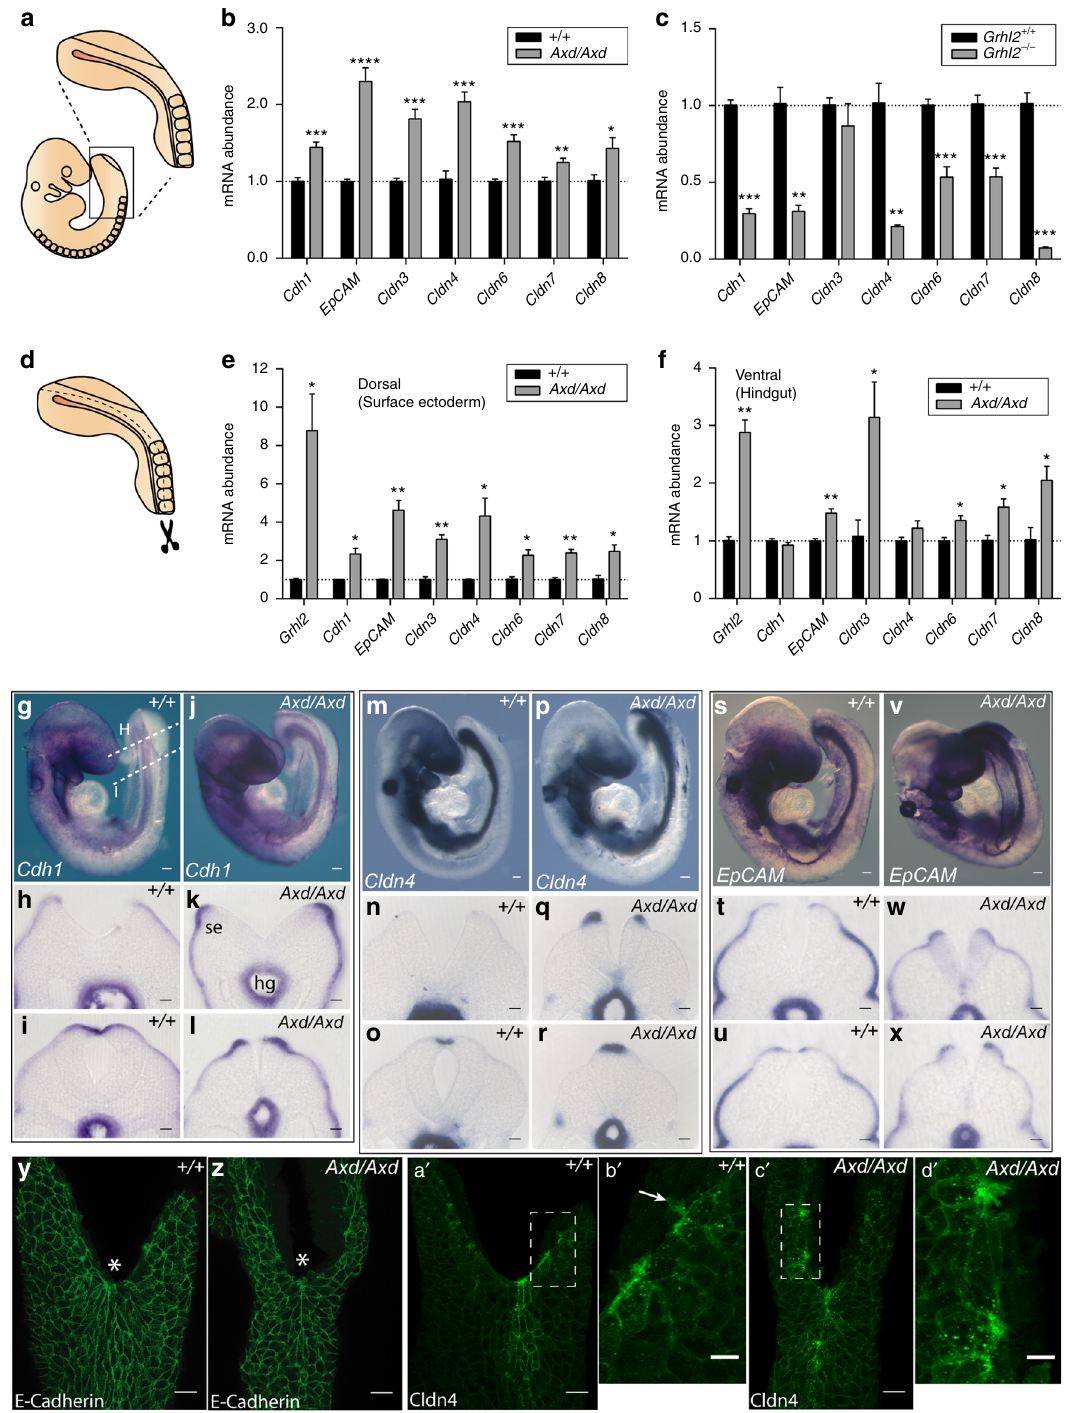
Fig. 3 Grhl2 regulates a molecular signature of epithelia in the surface ectoderm. a Schematic representation of an E9.5 embryo and caudal spinal region isolated for analysis. b – c qRT-PCR of Cdh1, EpCAM, Cldn 3,4,6,7, and 8 of samples derived from the whole-caudal spinal region (as in a ) ( n = 3 – 6 samples per genotype). d Schematic representation of the microdissection separating the dorsal (surface-ectoderm-containing) and the ventral (hindgut-containing) parts of the caudal spinal region. e , f qRT-PCR analysis of Cdh1, EpCAM, Cldn 3,4,6,7, and 8 of samples derived from microdissected spinal regions (as in d ) (>5 embryos pooled per sample; three samples per genotype). Data represent mean±SEM (**** p <0.0001, *** p <0.001, ** p <0.01, * p <0.05; t -test); (See Supplementary Fig. 3 for equivalent Grhl2 − / − data). WMISH con fi rmed upregulation of Cdh1 ( g – l ), Cldn4 ( m – r ), and EpCAM ( s – x ) in Axd/Axd compared with + / + embryos at E9.5 (examples at 17 – 19 somite stage). Transverse sections are at the levels indicated by dashed lines in g (se, surface ectoderm; hg, hindgut). Scale bars represent 100 µ m in whole mounts and 25 µ m on sections. y – d ʹ Dorsal view of PNP region (caudal end oriented upwards; asterisk indicates closure site) immunostained for E-cadherin ( y , z ) and Cldn4 ( a ʹ – d ʹ ). b ʹ and d ʹ show magni fi ed images of areas boxed in a' and c' , respectively. Scale bars indicate 25 μ m in y , z , a ʹ , c ʹ and 10 μ m in b ʹ and d ʹ . Images are representative of a minimum of three embryos per genotype. See also Supplementary Fig. 4 for additional WMISH of Cldn genes in Axd and Supplementary Fig. 5 for equivalent data in Grhl2 − / − . Source data are provided as a Source Data fi